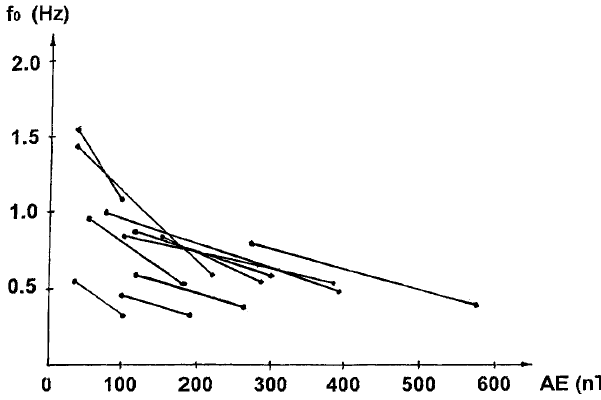
Fig. 6. The frequency variation of the late morning and prenoon nonstationary pulsations with